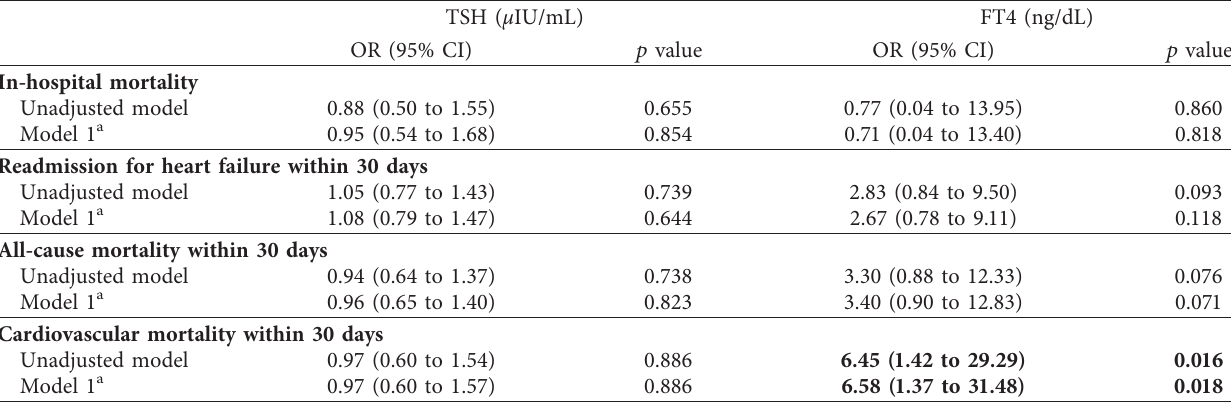
Figure 1: Comparison of (a) TSH and (b) FT4 levels in patients hospitalized and nonhospitalized within 30 days from discharge. TSH: thyroid-stimulating hormone; FT4: free thyroxine. Table 3: Association of thyroid function (TSH and FT4) with short-term clinical endpoints.